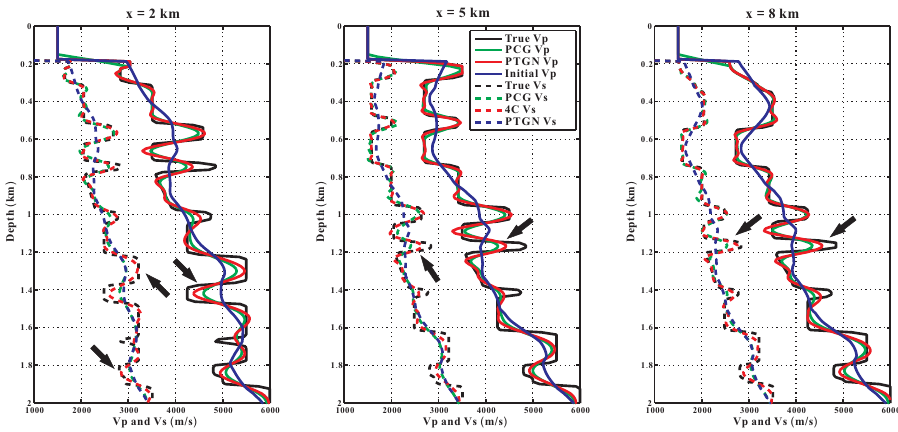
Figure 8. Vertical profiles of the inverted Vp (solid) and Vs (dashed) using the PTGN and PCG methods at horizontal distances of 2 km, 5 km, and 8 km.